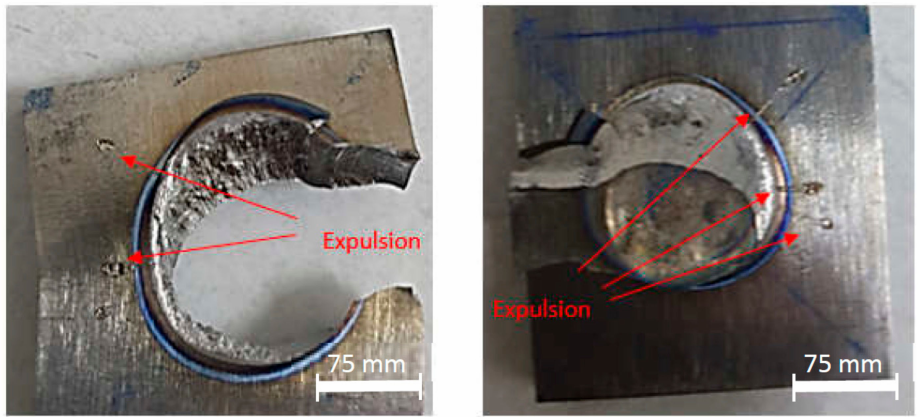
Figure 11. Expulsion under the conditions of a welding current of 10 kA, a welding time of 32 cycles, and a welding force of 4